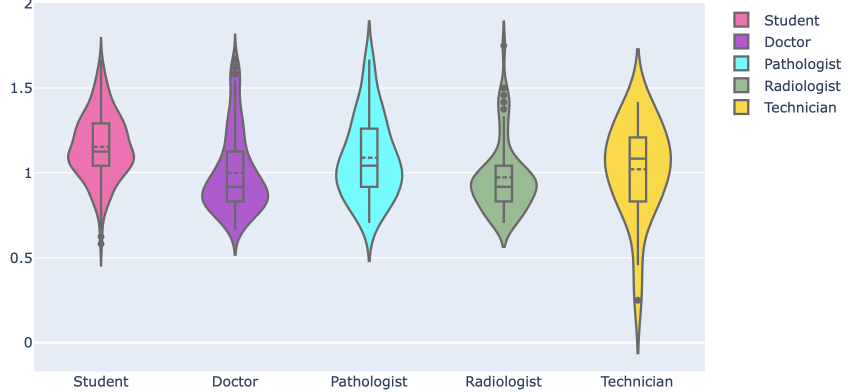
Figure 15. Average confidence score distribution among the professionals.